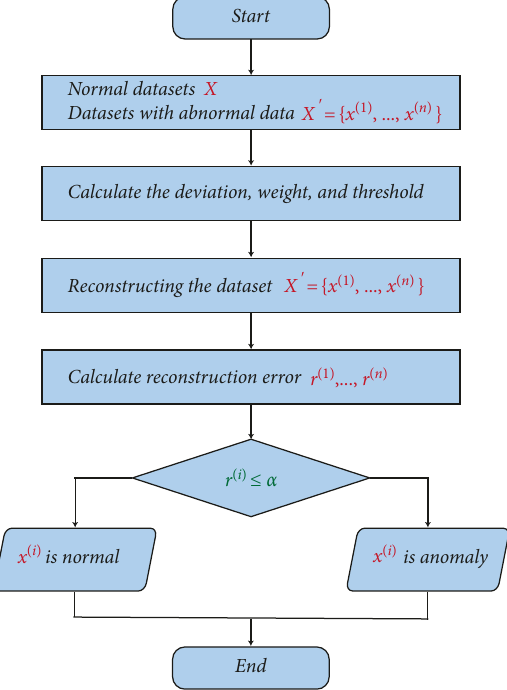
Figure 3: Autoencoder-based anomaly detection